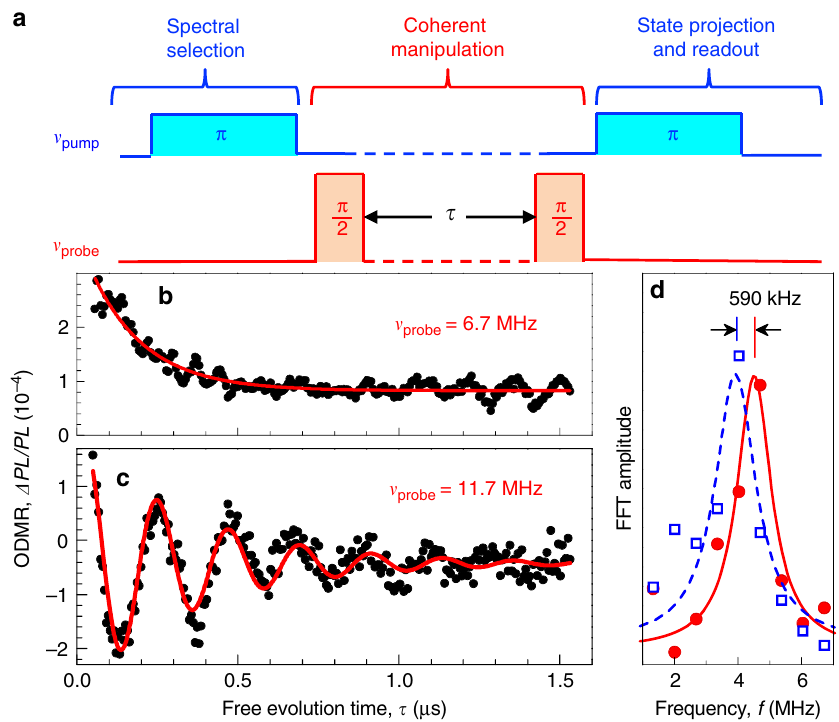
Fig. 4 Ramsey interferometry of spin qudit modes. a Pulse pattern for the spectral selection, coherent manipulation, and state projection followed by the readout of spin packets. b Ramsey measurement of the spin packet selected by v pump = 21.8 MHz in a magnetic fi eld of 223 ± 2 μ T. The probe frequency v = 6.7 MHz is set to the v fi t to an exponential decay with T (cid:6) ¼ 168 ± 7 ns . c The same as ( b ) but the probe probe 5 resonance. The solid line represents the 2 ¼ 357 ± 24 ns . frequency v probe = 11.7 MHz is detuned from the v 5 resonance. The solid line represents the fi t to an exponentially decaying sinusoid with T (cid:6) 2 d FFT of the Ramsey fringes fi tted to a Lorentz function. The solid line corresponds to the data from ( c ). The dashed line is for the same spin packet as in c but probed in a magnetic fi eld of 242 ± 3 μ T